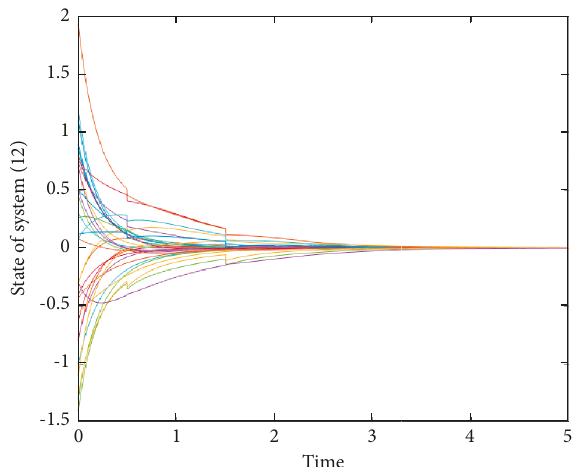
Figure 6: The state diagram of 8 nodes of system (14) when α